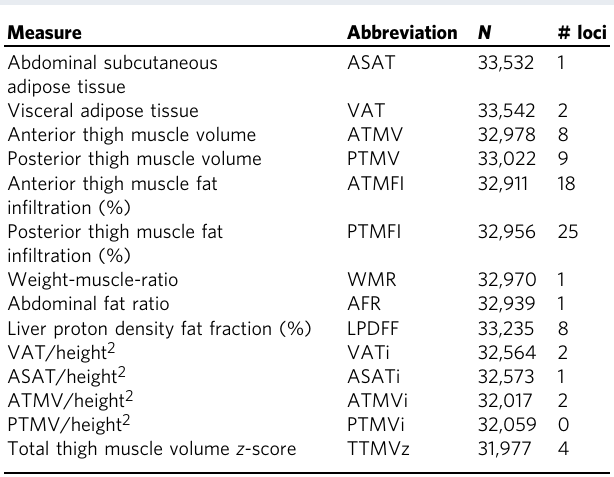
Table 1 MRI-derived measures of body composition included in this